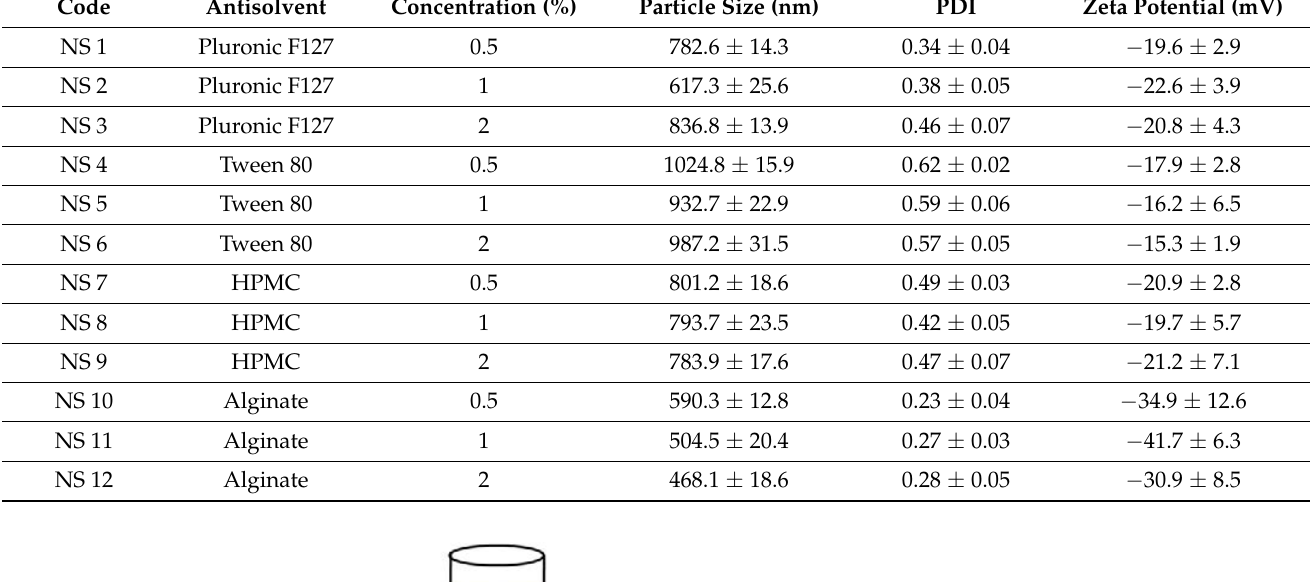
Table 1. Compositions, mean particle sizes, PDIs, and zeta potential values (means ± SD, n = 3) of different nanosuspension batches.